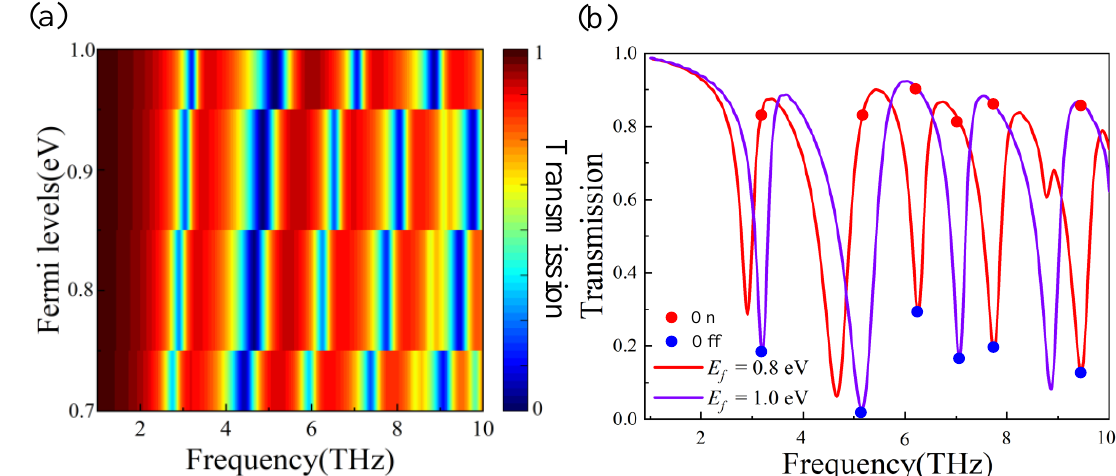
Figure 4. ( a ) Evolution of transmission spectra at different Fermi levels. ( b ) Comparison of the transmission spectra at E f = 0.8eV, and E f =